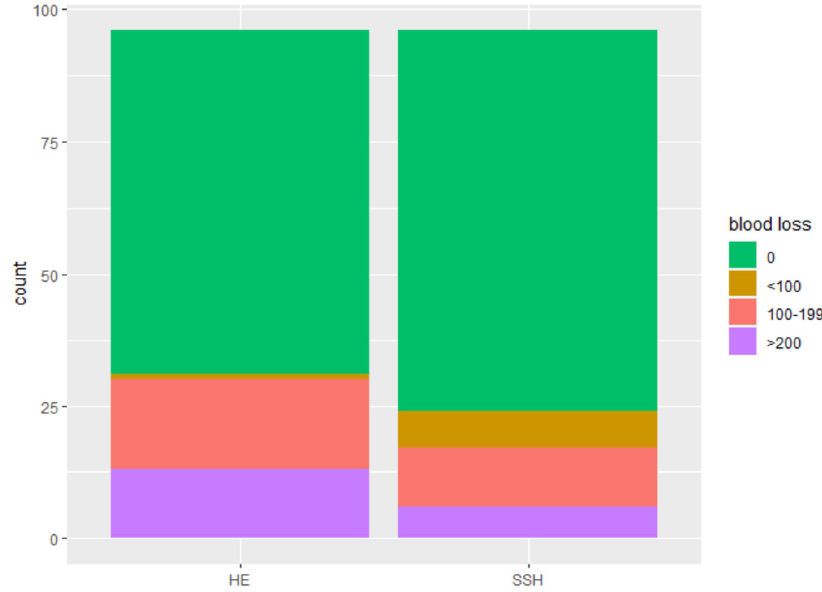
Figure 4. Intraoperative blood loss in milliliters. Table 2 . Primary outcomes .